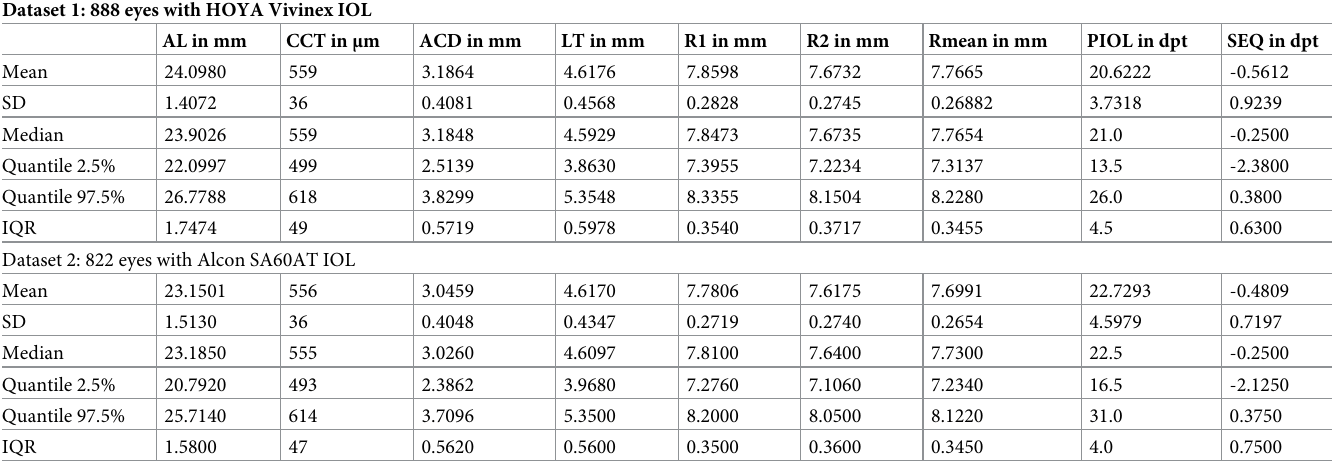
Table 1. Descriptive statistics of the 2 datasets with mean, standard deviation (SD), median, the lower (quantile 2.5%) and upper (quantile 97.5%) boundary of the 95% confidence interval, and the interquartile range IQR (quartile 75%—quartile 25%). AL refers to the axial length, CCT to the central corneal thickness, ACD to the external phakic anterior chamber depth measured from the corneal front apex to the front apex of the crystalline lens, LT to the central thickness of the crystalline lens, R1 and R2 to the corneal radii of curvature for the flat and steep meridians, Rmean to the average of R1 and R2, PIOL to the refractive power of the intraocular lens implant, and SEQ to the spherical equivalent power achieved 5 to 12 weeks after cataract